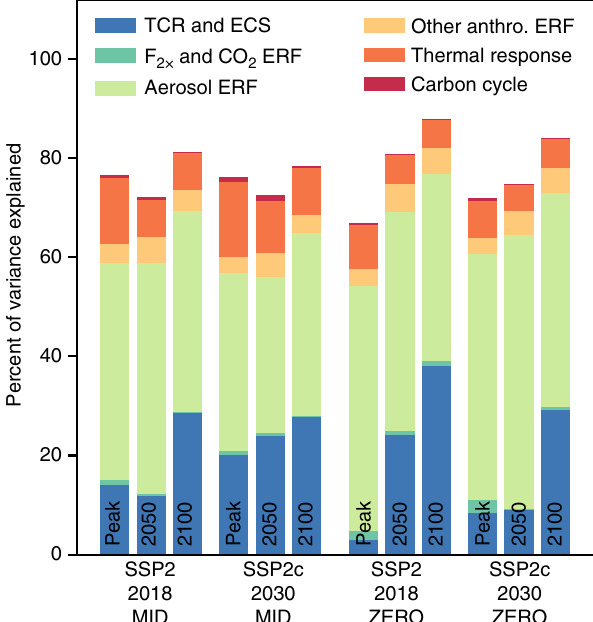
Fig. 4 First-order variance-based sensitivity analysis of the peak, 2050 and 2100 temperature changes for infrastructure commitments and zero emissions commitments starting in 2018 and 2030. SSP2-driving scenario is assumed with NDC conditional commitments for 2030 start dates. Note that variances do not add up to 100%, as covariance terms account for the